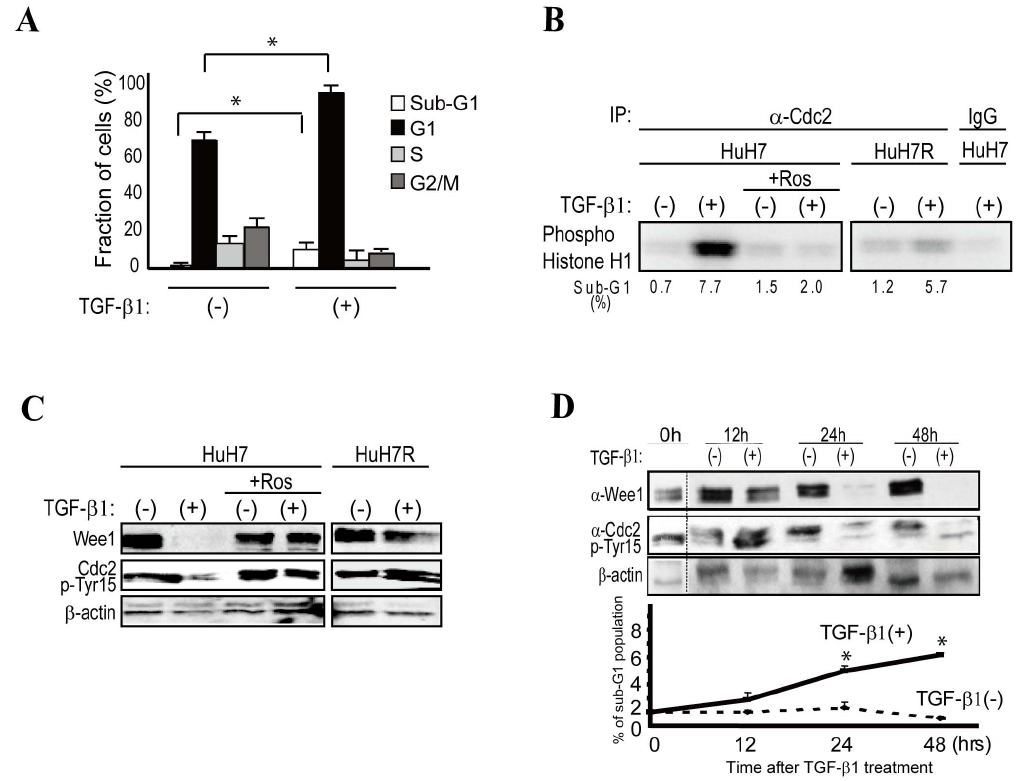
Figure 1. TGF-B1 induces apoptosis through cdc2 activation. A, FACS analyses showed that the sub-G1 phase HuH7 cell population increased from approximately 0.7% to 7.7%, and cells in the G1 phase increased from approximately 69% to 87% 48 h after TGF- b 1 treatment. Data represent the means 6 S.D. of three experiments. * indicates significant differences between each group (P , 0.05). B, Cdc2 kinase activity was determined based on the level of phosphorylated histone H1 using histone H1 as a substrate. Cdc2 was activated 48 h after TGF- b 1 treatment in HuH7 cells. However, cdc2 was not activated in HuH7R cells, which were isolated as an apoptosis-resistant clone from TGF- b 1-treated HuH7 cells. Roscovitine (Ros)-pretreated HuH7 cells did not show cdc2 activation. A representative image from three independent experiments is shown. C, After TGF- b 1 treatment (48 h), we observed cdc2 Tyr15 dephosphorylation in association with Wee1 kinase down-regulation in apoptotic cells. Pretreatment with 20 m M roscovitine completely abolished apoptosis and restored Wee1 kinase expression. TGF- b 1 treatment induced G1 cell cycle arrest in HuH7R cells; however, Wee1 kinase expression and non-phosphorylated cdc2 Tyr 15 were similar to those of roscovitine-pretreated HuH7 cells. A representative image of three experiments is shown. D, Wee1 down-regulation and cdc2 Tyr15 dephosphorylation commenced approximately 24 h after TGF- b 1 treatment, which was similar to thea initiation of apoptosis. A representative Western blot image is shown in the upper panels. The results in the lower graphs represent the means 6 S.D. of three experiments. * indicates significant differences between each group (P , 0.05).